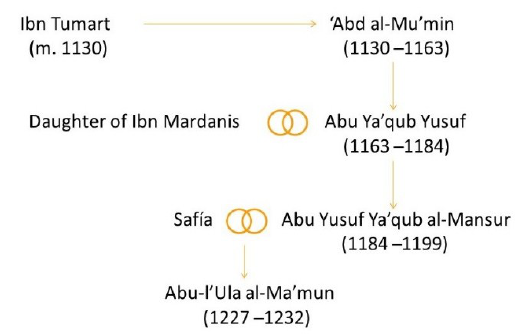
Figure 9. Marriages between the Almohad and Mardanīšī dynasties. Drawing made by author.